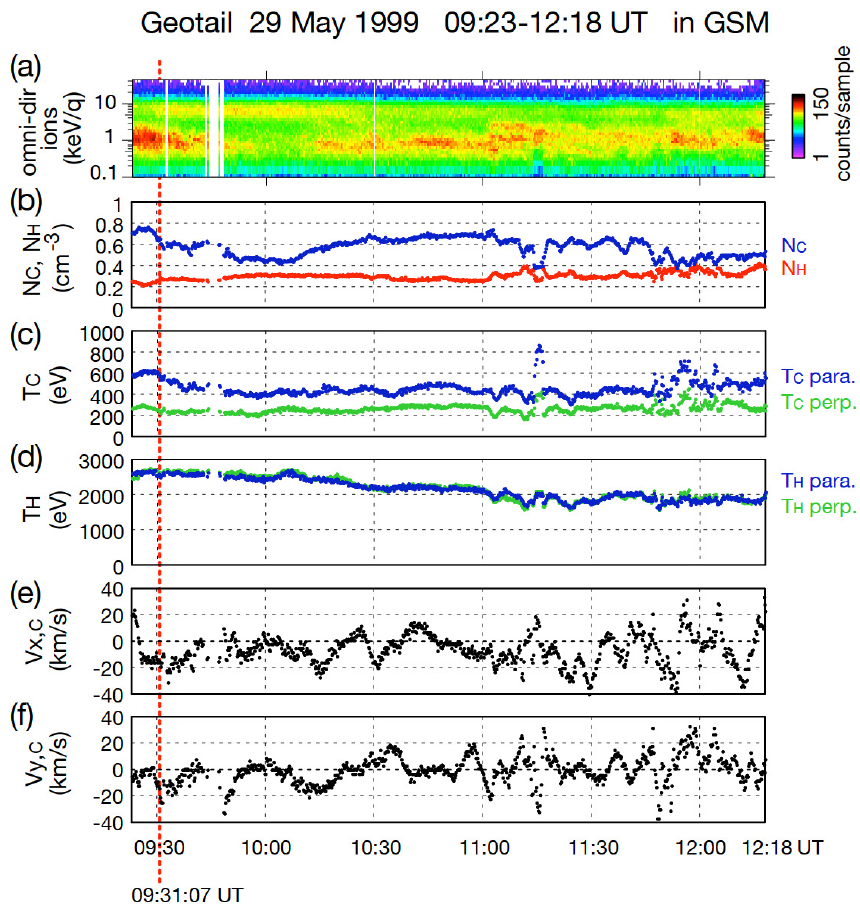
Fig. 5. Expansion of the Geotail observations between 09:23–12:20 UT during which the two-component protons were observed and the 3-D count data exist. From the top, (a) E-t spectrogram of omni-directional ions, (b) densities of the cold and hot components, (c) perpendicular and parallel temperatures of the cold component, (d) temperatures of the hot component, (e, f) X and Y components of the velocity of the cold component are shown. The perpendicular (parallel) temperature is plotted by the green (blue) points, and the density of the cold (hot) component is done by the blue (red)